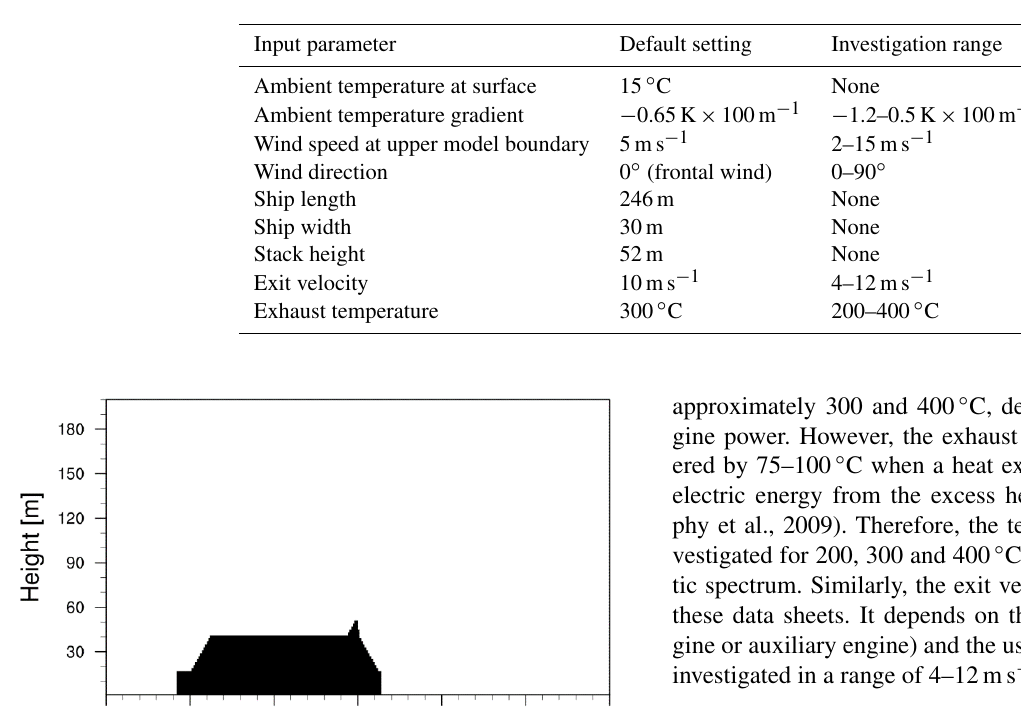
Table 1. Input parameters for this study. While varying a single input parameter in the investigation range, all others remain at default setting.